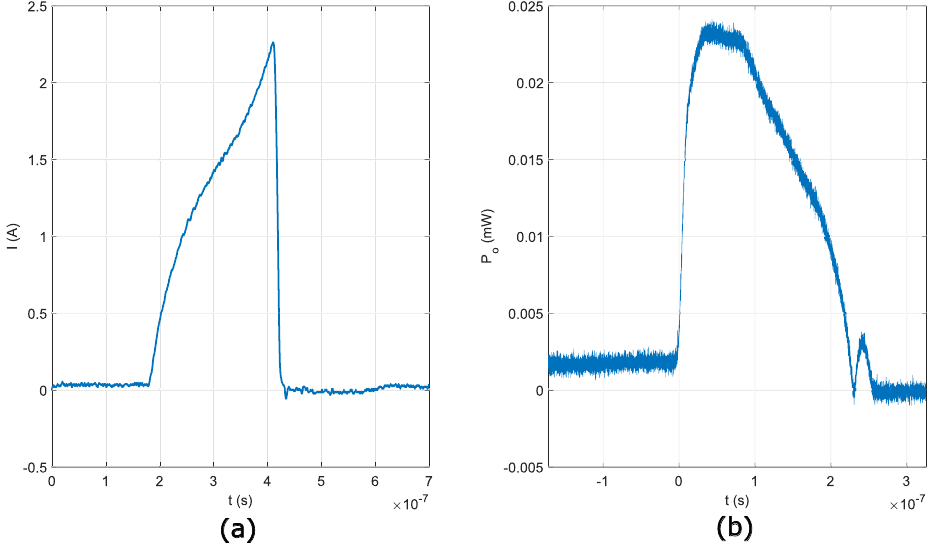
Figure 4. DFB laser diode ’s: ( a ) driving current waveform, ( b ) emitted optical signal.